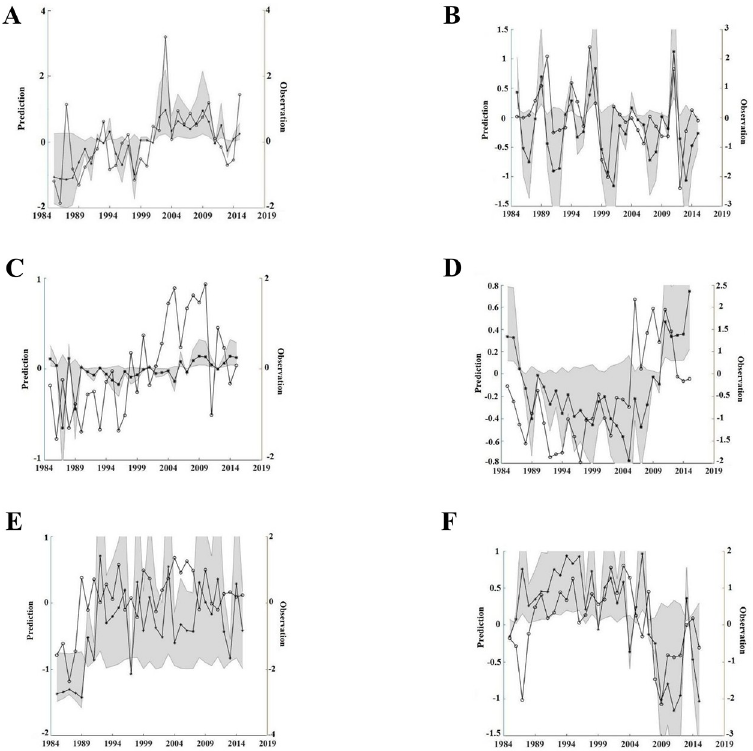
Fig 5. DDDBN model predictions. Generated predictions by the DDDBN model for spring zooplankton (A), fall zooplankton (B), white shrimp (C), brown shrimp (D), red snapper (E) and King mackerel (F). The series marked with stars denote the predictions as opposed to the observed standardized data denoted by circles. 95% confidence intervals (highlighted in gray color) report bootstrap predictions’ mean and standard deviation. Note the negative scale is due to standardization.